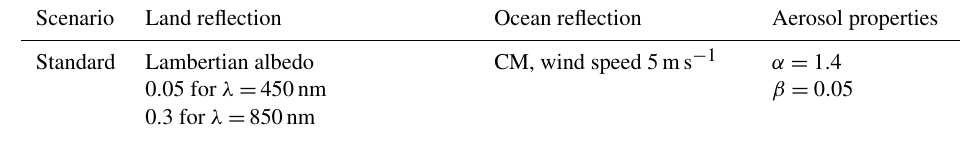
Table 1. Model input parameter description for the three scenarios regarding land and ocean BRDF and